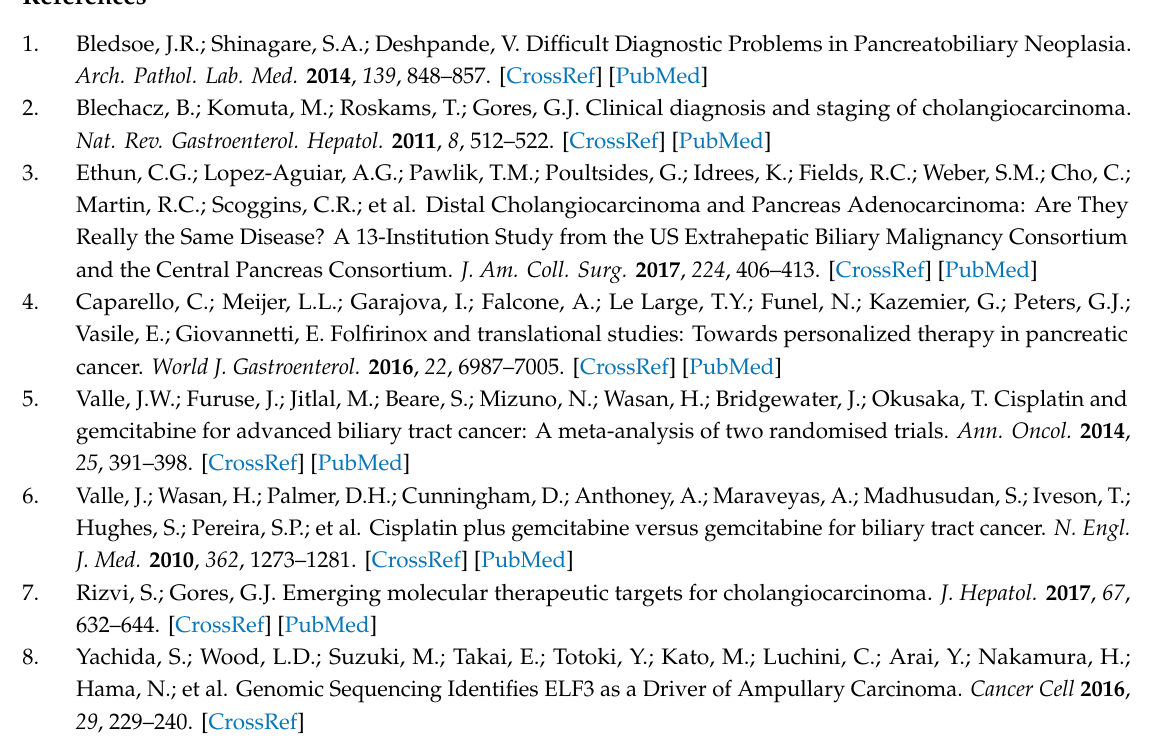
expression of the reference gene combination miR-93 and miR-101 (A) and cel-miR-39 (B) in the evaluation phase and validation phase. Box plots are displayed for the average raw Cq-values, with the horizontal lines representing the mean ± SD. The table (C) displays the stability values of the potential reference miRNAs, as calculated by NormFinder. Figure S3. ROC-curves of the individual microRNAs evaluated in the evaluation phase, comparing distal CCA to healthy controls. ROC-curves with AUC are displayed. Figure S4. Individual miRNA expression profiles of the miRNAs investigated in the validation phase. Expression levels of miR-34a (A), miR-22 (B), miR-122 (C), and miR-197 (D) comparing distal CCA to benign disease and PDAC. No significant di ff erences were found for these miRNAs. Normalized Cq ( ∆ Cq) are shown, box plots are displayed for the average ∆ Cq-values, with the horizontal lines representing the mean ± SD. Figure S5. Expression of miR-16 (A) and miR-877 (B) in early stage (I / II) and late stage (III / IV) distal cholangiocarcinoma. Expressions of miR-16 was significantly lower in late stage distal cholangiocarcinoma.Figure S6. Expression of bilirubin levels in patients with benign disease versus distal CCA and distal CCA versus PDAC. Figure S7. Expression levels of miR-877 (A) and miR-16 (B) in plasma samples of patients with distal CCA compared to perihilar and intrahepatic CCA. No significant di ff erences were found between the expression levels of the groups. Normalized Cq ( ∆ Cq) are shown, box plots are displayed for the average Cq-values, with the horizontal lines representing the mean ± SD. CCA = cholangiocarcinoma. Table S1—Overview of the 12 miRNAs selected for evaluation and the P-value comparing distal CCA to healthy controls in the evaluation phase. Table S2. Predicted gene targets of miR-16–5p and miR-877–5p. Table S3. Clinicopathological characteristics of the included patients with distal CCA, perihilar CCA, and intrahepatic